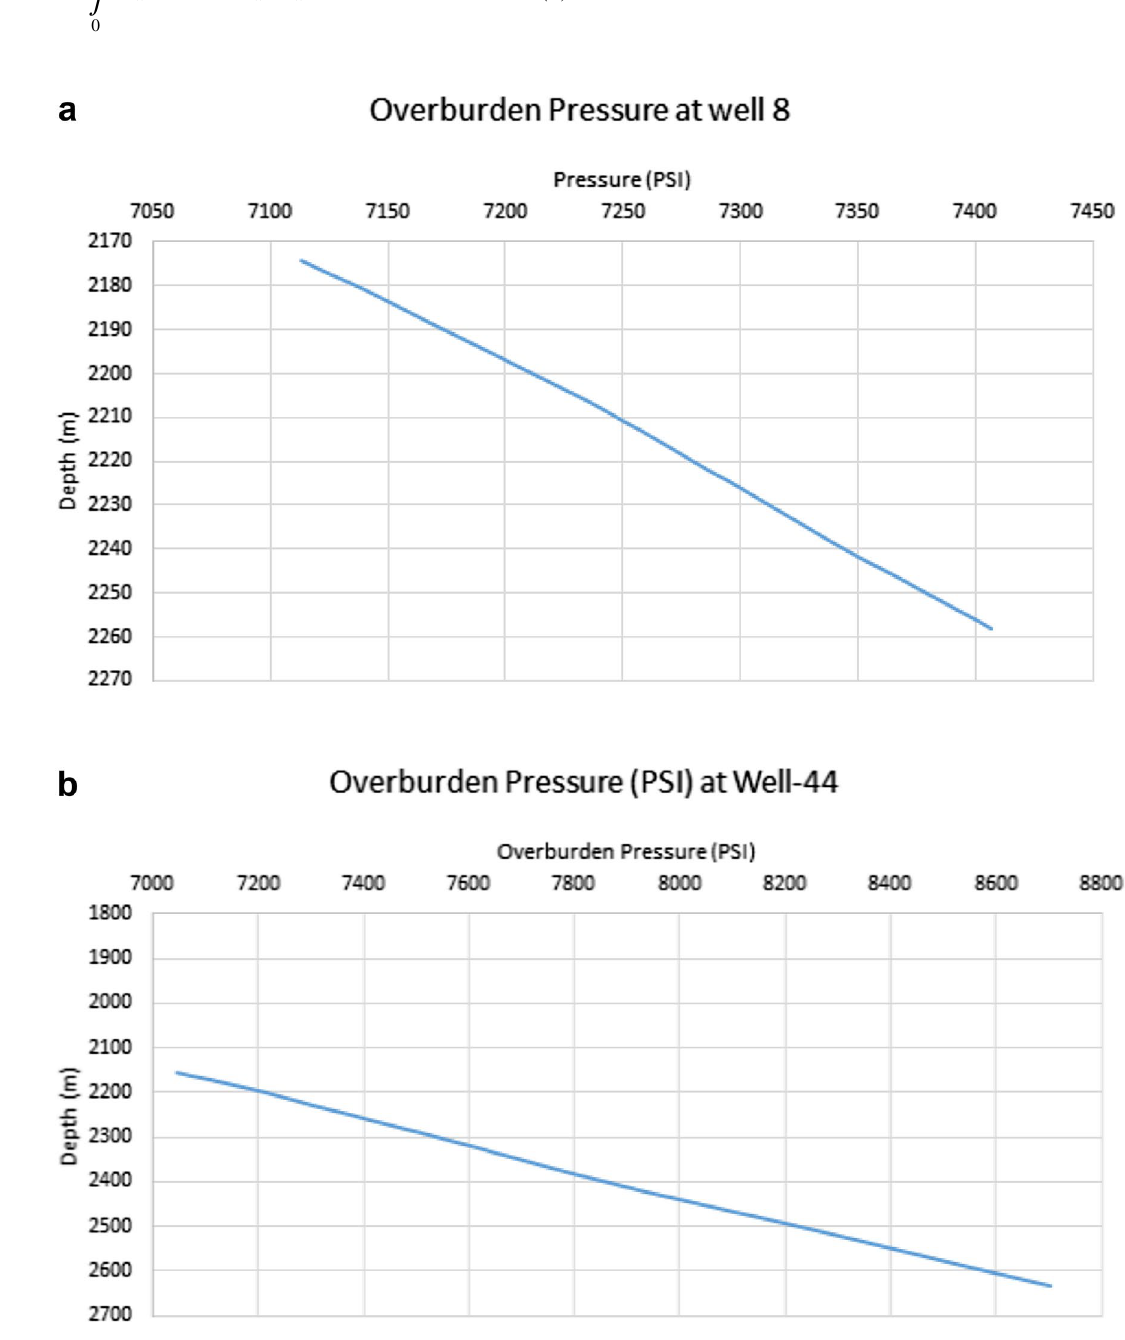
Fig. 1 The overburden pressure at a well no. 8 and b well no.